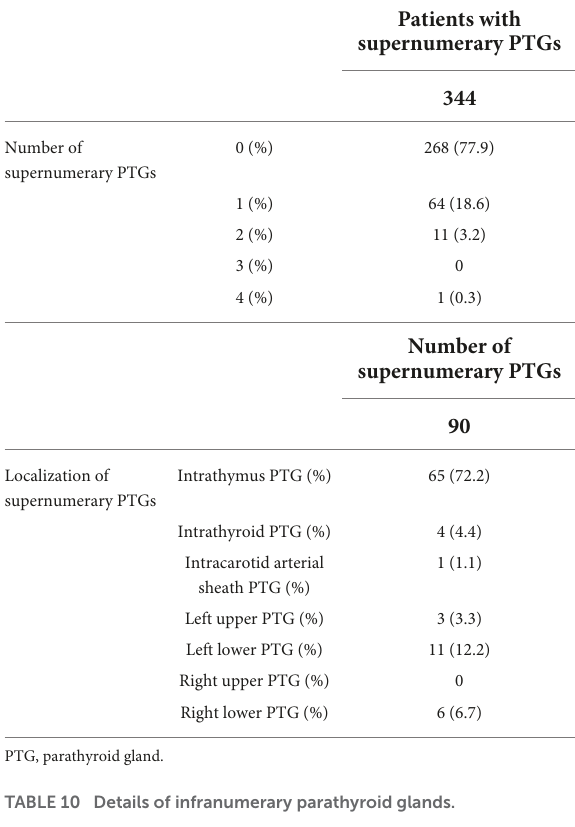
TABLE 9 Details of supernumerary parathyroid glands.